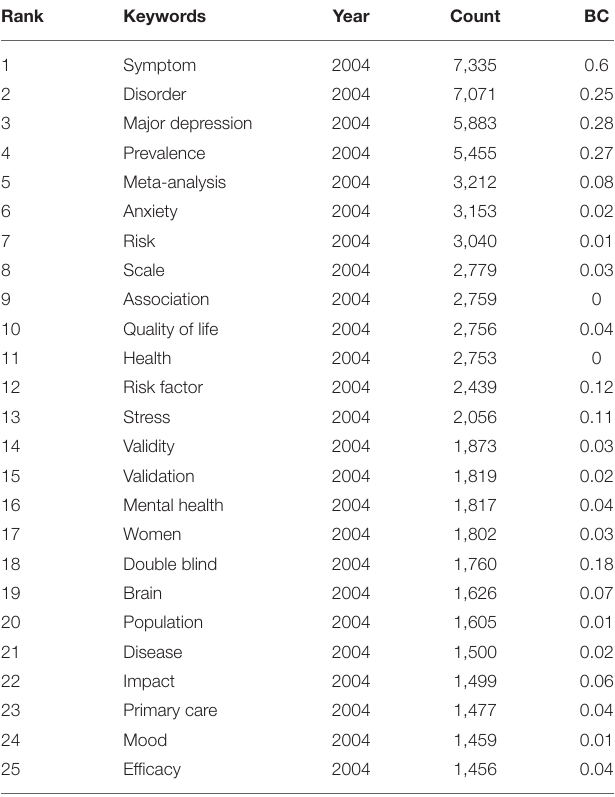
TABLE 8 | Top 25 frequent keywords in the period of